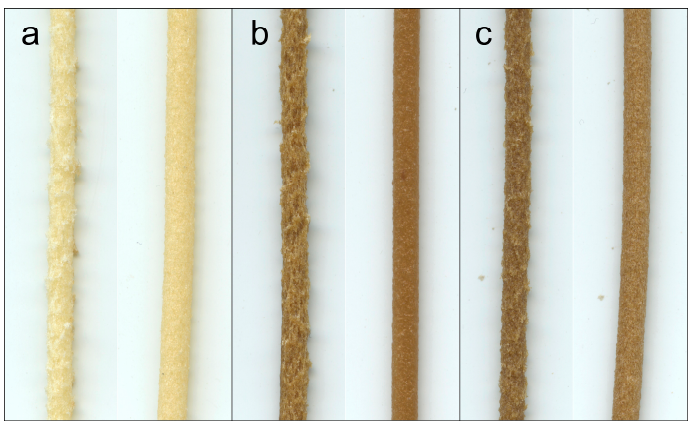
Figure 4. Comparison of the roughness in the filaments produced from BioPE1 (left) and BioPE2 (right) with fibers loads of 20%: ( a ) B1-T20 and B2-T20; ( b ) B1-LGT20 and B2-LGT20; ( c ) B1-OGT20 and B2-OGT20.